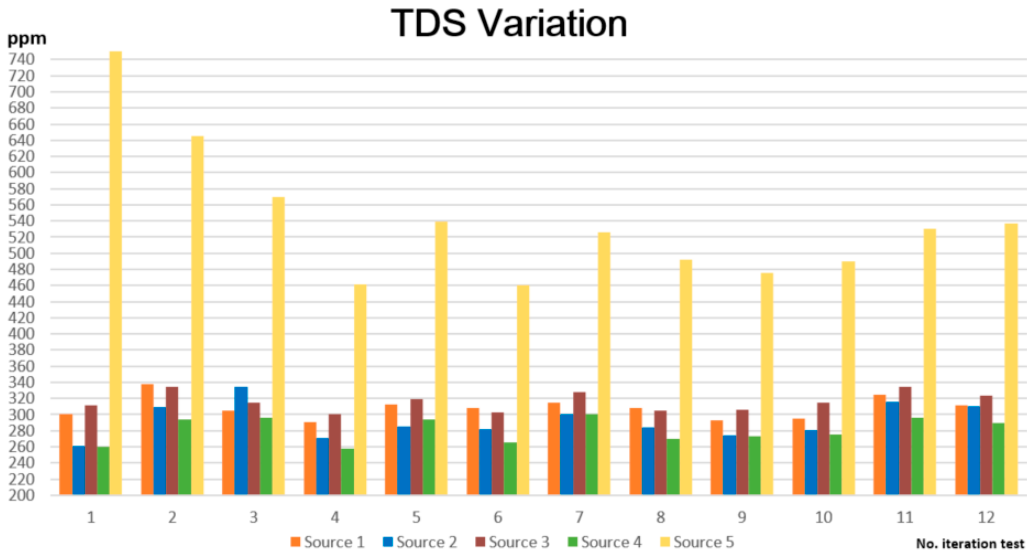
Figure 11. TDS variation for the tested water sources.